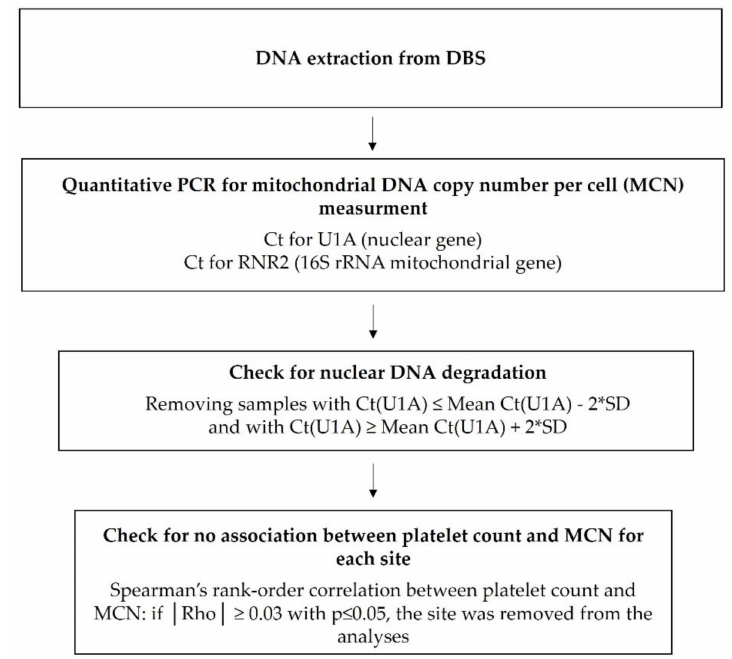
Figure 1. Analysis flow for mitochondrial DNA copy number per cell assessment. Abbreviations: DBS, dried blood spot; PCR, polymerase chain reaction; Ct, cycle threshold; SD standard